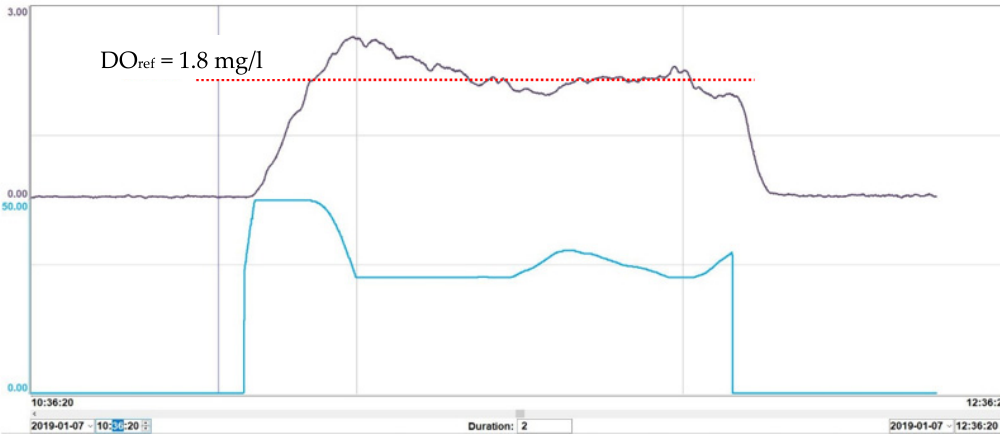
/ l] control–zoomed Figure 4. Historical data of DO [mg O 2 /l] control–zoomed [15]. Figure 4. Historical data of DO [mg O 2 Figure 4. Historical data of DO [mg O 2 /l] control–zoomed [15].